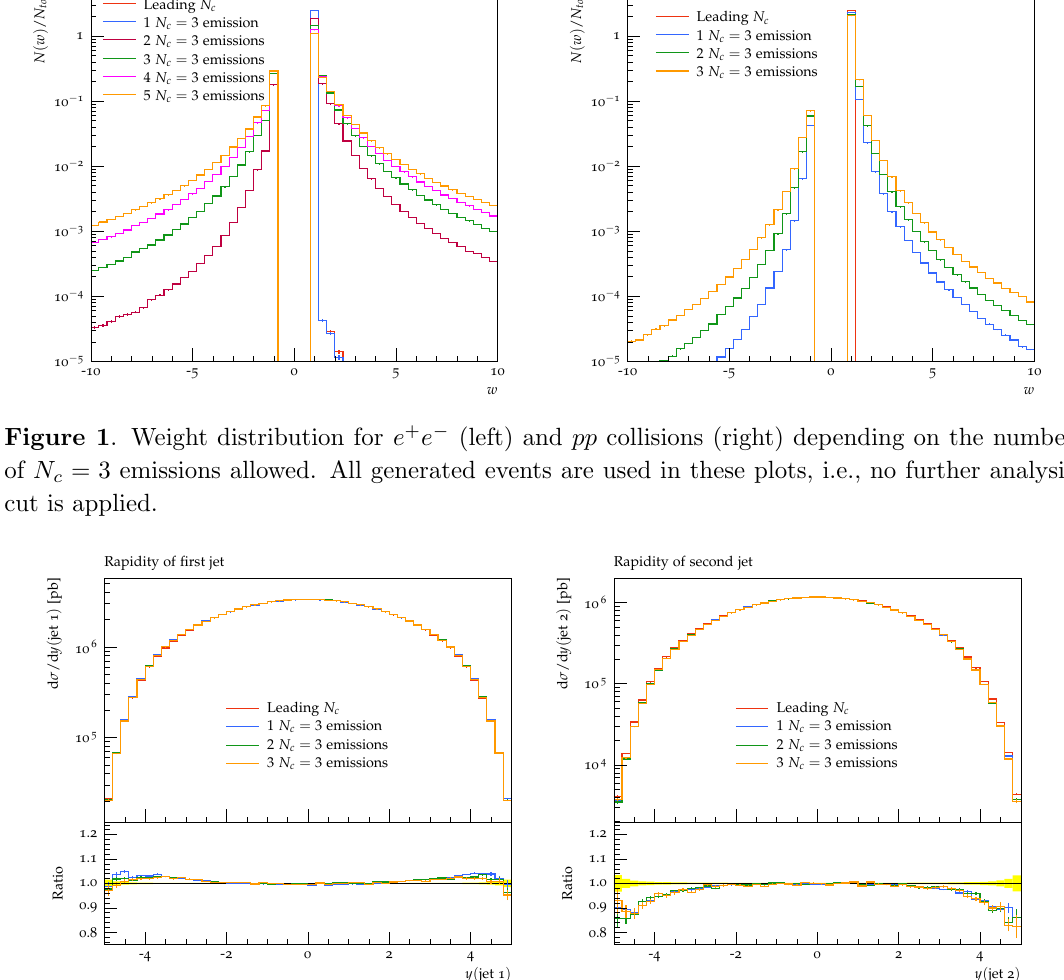
Figure 2 . Rapidity distribution of the (cid:12)rst and second jet as zero, one, two and three N c = 3 emissions are